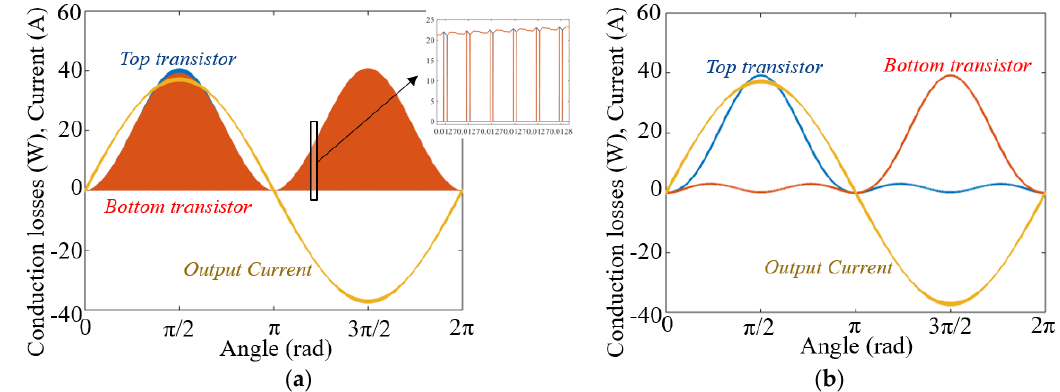
Figure 5. ( a ) Instantaneous values of conduction losses in the top and bottom switches of one bridge leg of a three-phase inverter; ( b ) instantaneous values averaged over a switching period. Parameters were V DC = 540 V, I out = 26.3 A, φ = 0°, M i = 1, F sw = 50 kHz. The pulse width modulation (PWM) method used was sinusoidal (SPWM).